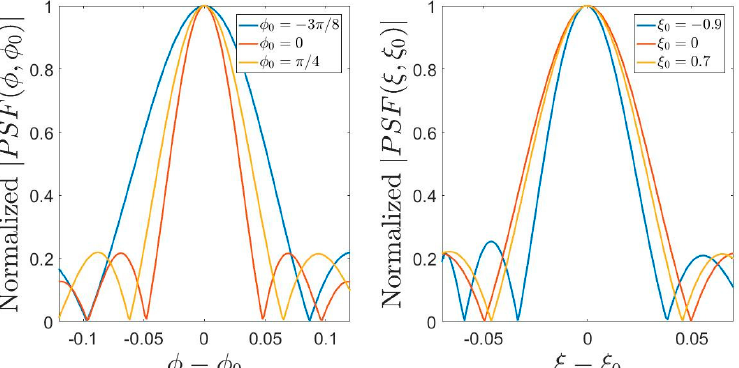
Figure 11. Normalized and overlapped PSFs of L θ (left panel) and L u (right panel) operators of a semi-elliptic source, with a x = 10 λ and a z = 5 λ , for φ 0 = − 3 π /8, 0, π /4 and for the corresponding values ξ 0 = − 0.9, 0, 0.7.